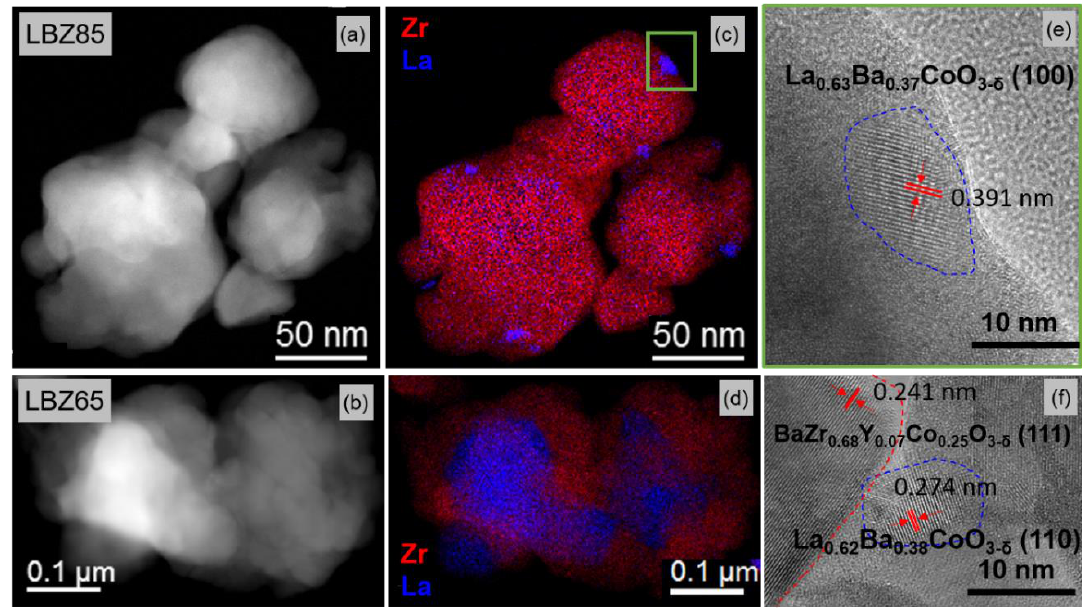
Figure 7. High angle annular dark field scanning transmission electron microscopy (HAADF-STEM) micrographs of ( a ) LBZ85 and ( b ) LBZ65 cathodes. ( c ) EELS combined map of Zr M4,5 edges and La M4,5 edges. ( d ) Energy Dispersive X-Ray Spectroscopy (EDS) combined map of Zr Kα + Lα and La Lα. High resolution TEM magnified region of ( e ) LBZ85 and ( f ) LBZ65. Approximate circumference of the grains are marked as guide for the eye.